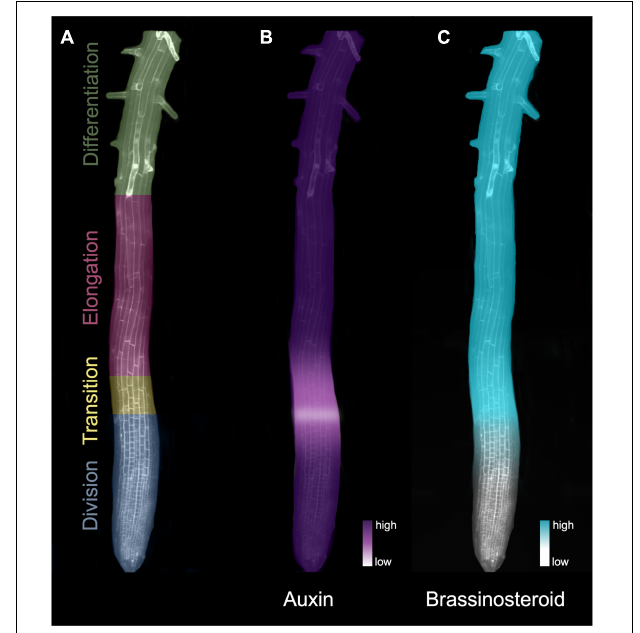
FIGURE 1 | Hormone gradients define the developmental zones of the Arabidopsis root apical meristem. (A) Developmental zones of the root indicated in different colors. (B) The auxin signaling gradient in the root meristem. Auxin levels drop substantially at the beginning of the transition zone, forming an auxin minimum before increasing again toward the elongation zone. (C) The BR signaling gradient increases at the transition zone in the root meristem. The heatmaps in B) and C) denote levels of hormone (auxin) and signaling